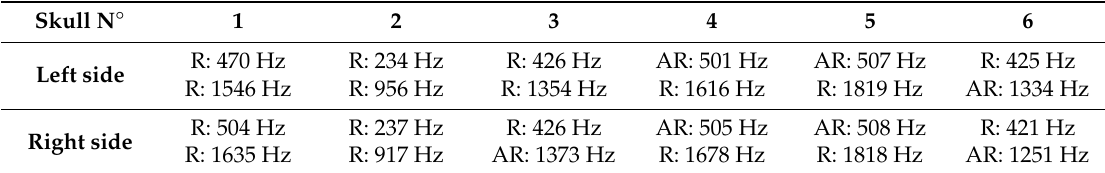
Table 2. Limit values of “ranges of di ff erences”.